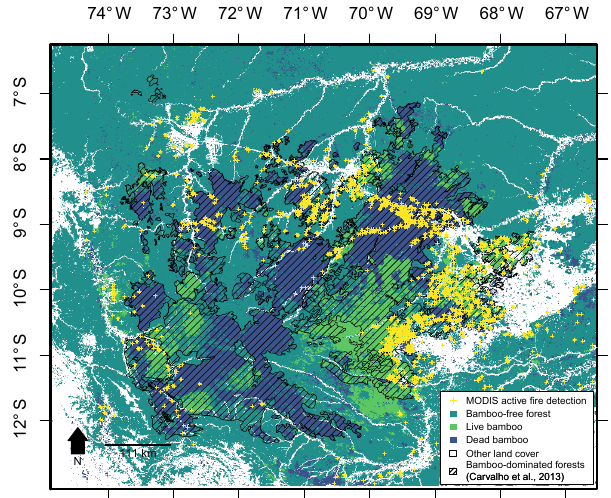
Figure 6. Bamboo-dominated forest map and MODIS active fire detections during 2002–2017 (yellow crosses). Blue pixels are bam- boo die-off patches detected during 2001–2017 using the bilinear model. Light green pixels are bamboo that did not die off, but showed increasing NIR signal during 2001–2017 and presented greater NIR mean than forest. Dark green pixels are bamboo-free forests. White pixels are other land cover classes. The hatched poly- gon represents the bamboo-dominated forests delineated by Car- valho et al.